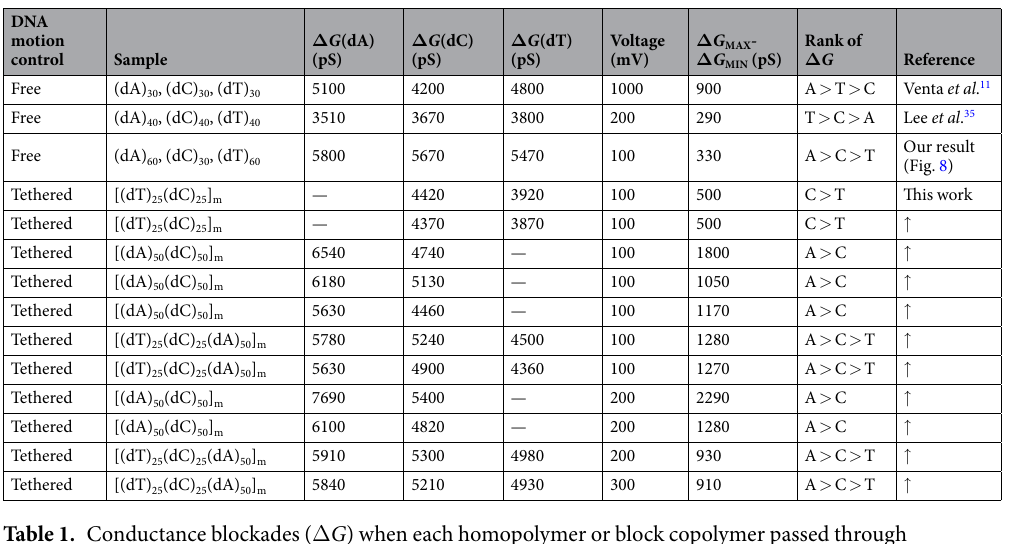
Table 1. Conductance blockades ( Δ G ) when each homopolymer or block copolymer passed through or remained in nanopores. Δ G was defined as the peak value of Gaussian fits to each histogram. All data (including the data from two previous studies) were acquired using Si 3 N 4 nanopores and in 1 M KCl aqueous solution. Δ G values obtained during the free (untethered) ssDNA translocations through nanopores are listed in the top three rows. Δ G values obtained when tethered ssDNAs remained in nanopores are listed at or below the fourth